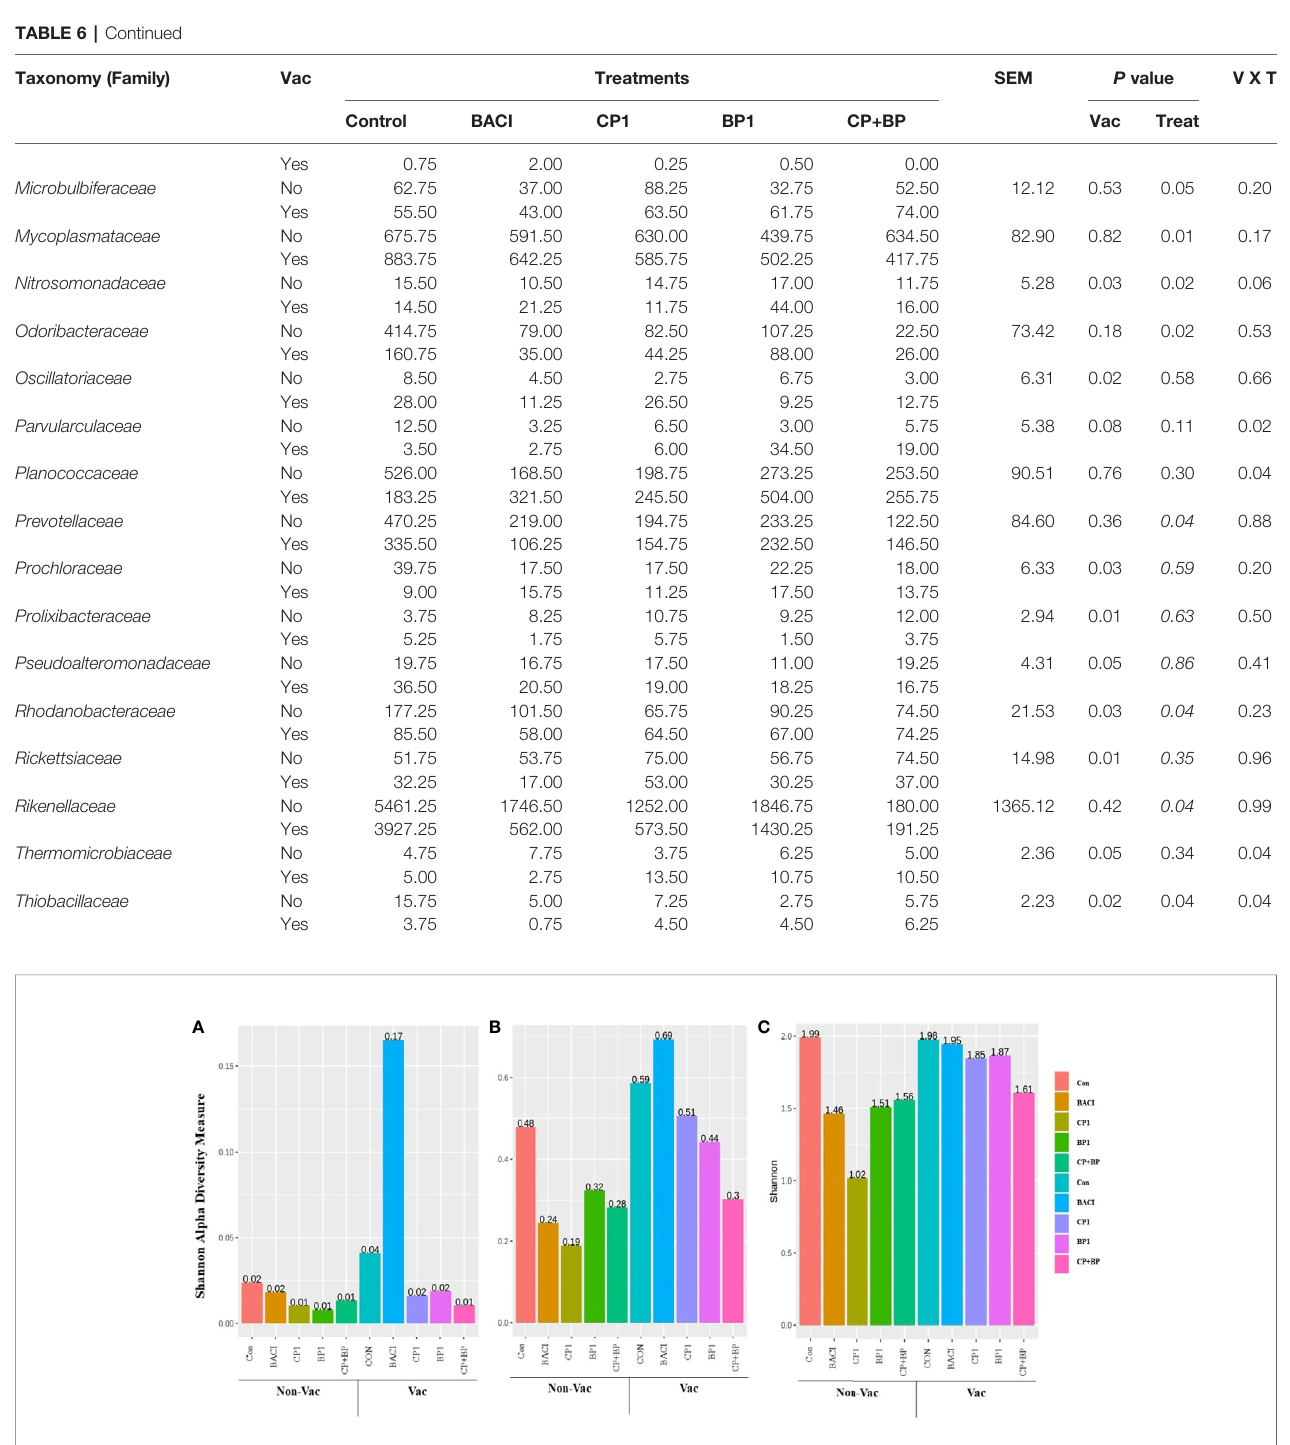
FIGURE 6 | Shannon alpha diversity of 21-days old chicken ceca (A) at the domain level, (B) at the phylum level, and (C) at the family level. Shannon alpha diversity was signi fi cantly decreased in CP1-fed birds from the non-vaccinated group at the family level compared to controls ( P =